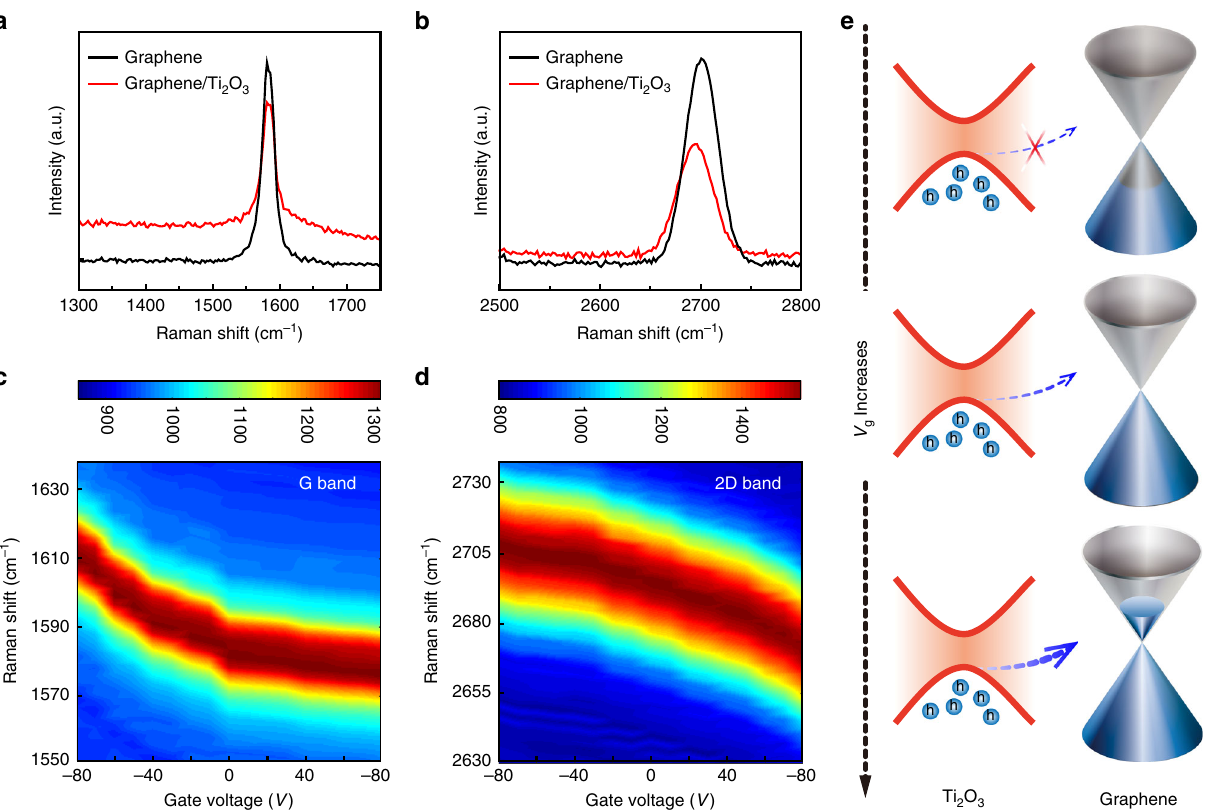
Fig. 3 Charge transfer and band alignment in the hybrid graphene/Ti 2 O 3 structure. a G-peaks (~1580 cm − 1 ) of the Raman spectra measured on the hybrid graphene/Ti 2 O 3 and the reference graphene samples without gating voltage. b 2D-peaks (~2700 cm − 1 ) of the Raman spectra measured on the same samples without gating voltage. c , d Evolution of the G and 2D Raman peaks, respectively, of the hybrid graphene/Ti 2 O 3 sample under different gate voltages. e Illustration of the band alignment and the charge transfer at the hybrid graphene/Ti 2 O 3 interface. It is illustrated that holes can only transfer from p-type Ti 2 O 3 to the graphene layer when the graphene is gated properly. Gray and lightblue regimes represent conduction and valance band,